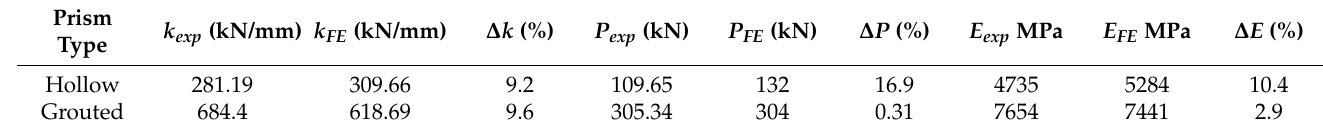
Table 1. Experimental and FE results (strength and stiffness).